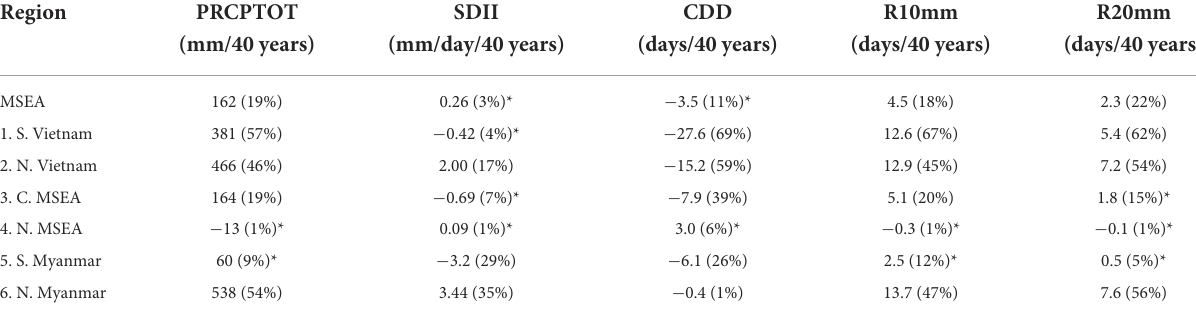
TABLE 2 Trends in extreme precipitation indices averaged over MSEA and the 6 sub-regions considered in this study based on the global unified gauge-based analysis of Daily Precipitation–Climate Prediction Center (CPC) over